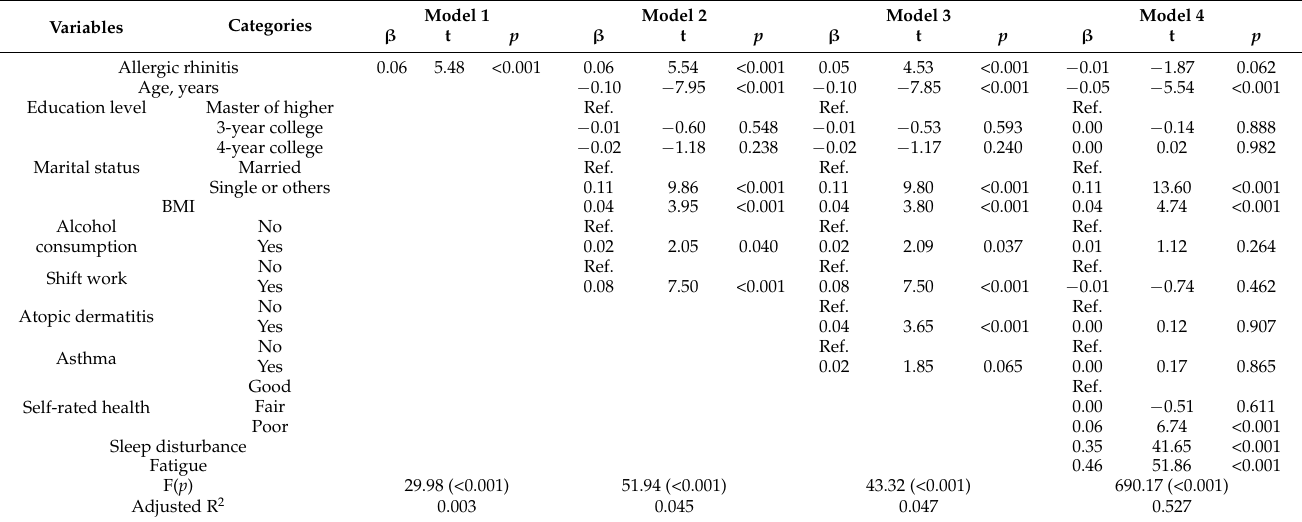
Table 5. Effects of allergic rhinitis on depressive symptoms ( N =